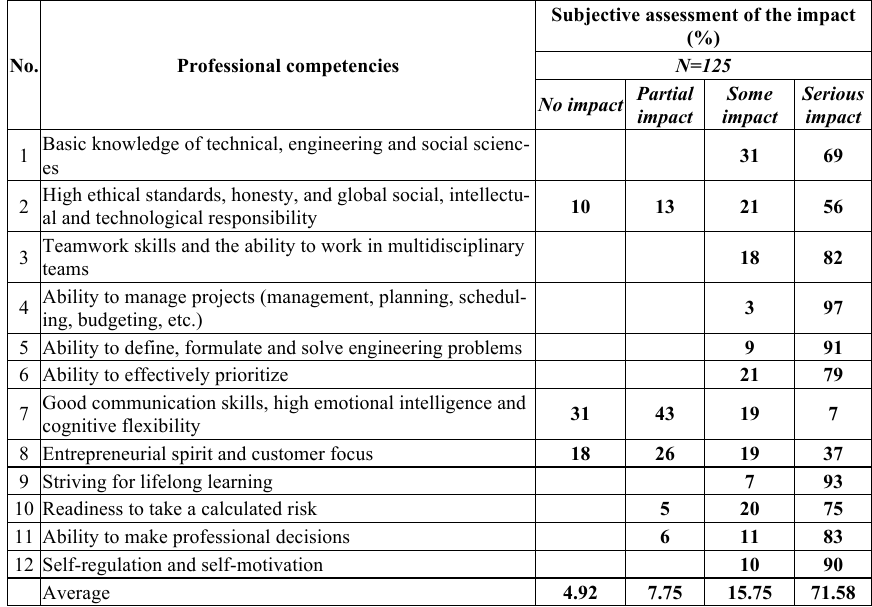
tencies of a modern engineer